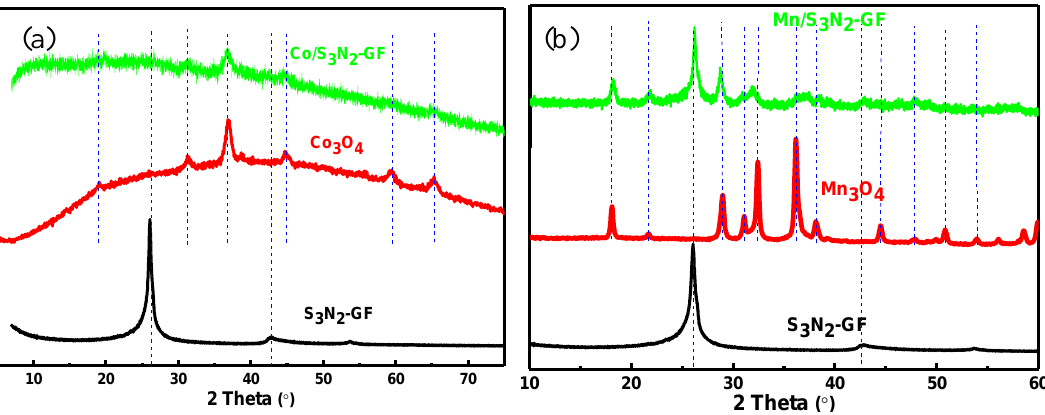
Figure 3. X-ray diffraction spectra of Co/S 3 N 2 –GF ( a ) and Mn/S 3 N 2 –GF ( b ) and the individual elements Figure 3. X-ray di ff raction spectra of Co / S 3 N 2 –GF ( a ) and Mn / S 3 N 2 –GF ( b ) and the individual elements (S 3 N 2 –GF and metal oxide NPs). (S 3 N 2 –GF and metal oxide